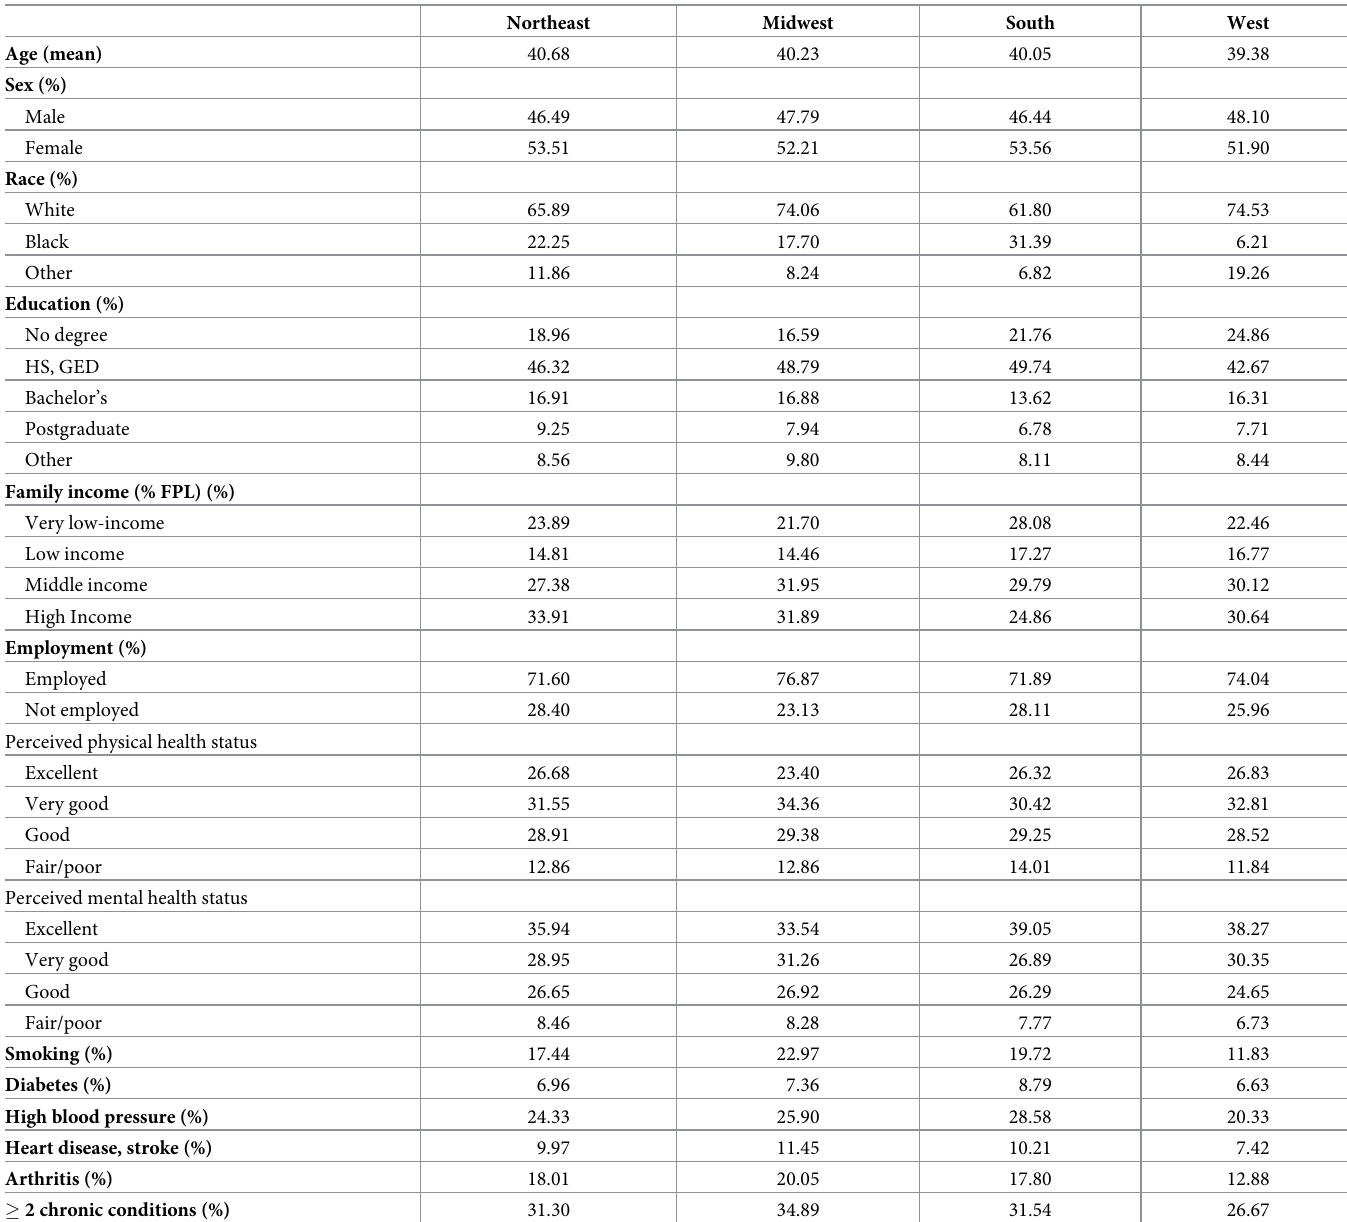
Table 1. Characteristics of the study population by Region, MEPS, 2010-2017. Northeast Midwest